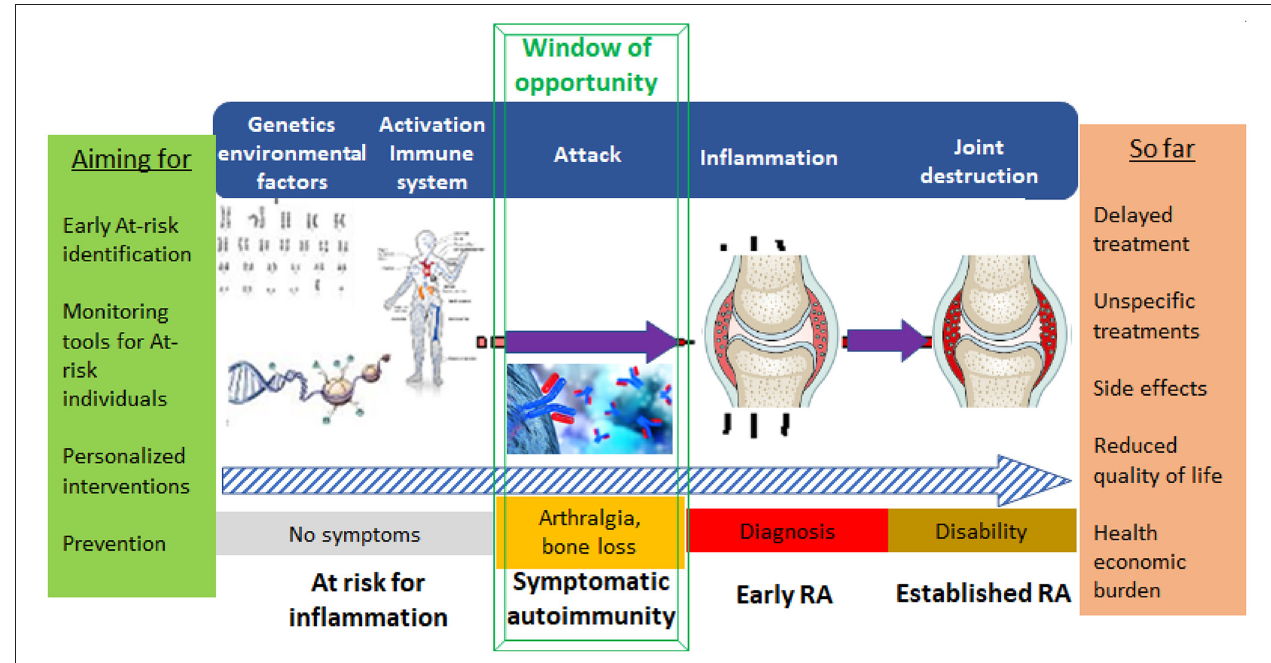
FIGURE 1 | Visualizing the development of RA and key aims in future healthcare management of people in different stages/phenotypes at-risk of developing